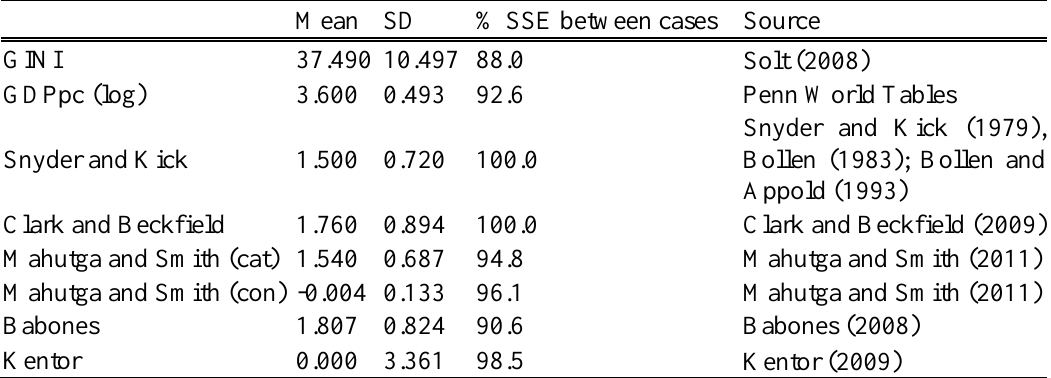
Table 2. Descriptive Statistics and Sources for Variables Used in the